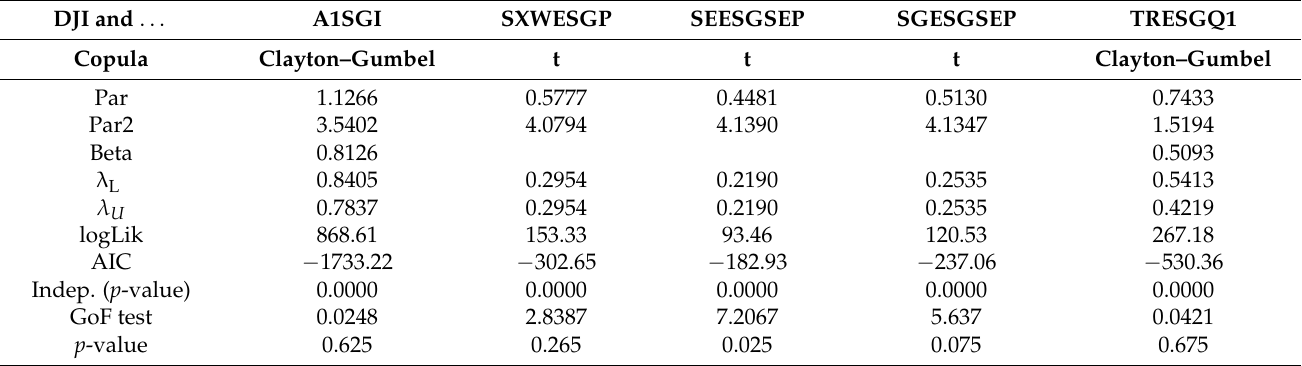
Table 9. Dependence structure for DJI and ESG indices, 3 June 2014–31 January 2017. DJI and . .